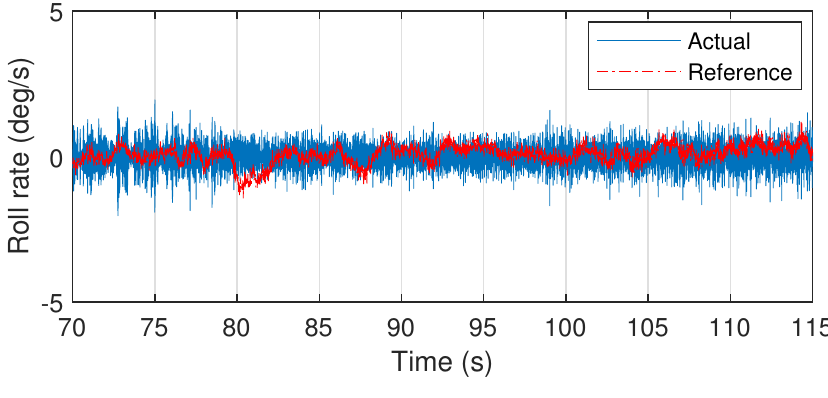
Figure 22. Roll angular angle.